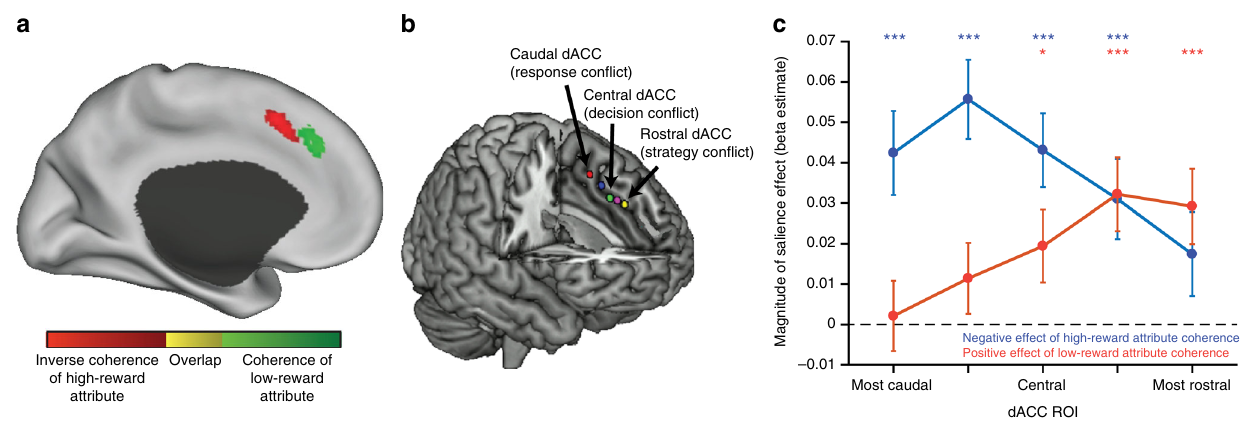
Fig. 4 dACC encoding of attribute coherence varies along rostrocaudal axis. a A nonparametric whole-brain analysis revealed that more caudal regions of dACC negatively tracked the coherence of the high-reward attribute (red) and more rostral regions positively tracked the coherence of the low-reward attribute (green). Activations re fl ect t -statistics ( t > 3.35, p < 0.001), extent-thresholded to achieve a cluster-corrected family-wise error p < 0.05, and are displayed on the in fl ated CARET surface. b , c This rostocaudal pattern was con fi rmed with a set of independent ROIs drawn from an earlier study 32 (shown in b ), which proposed that these re fl ect a range of uncertainty/con fl ict levels, from low-level responses (e.g., motor actions) most caudally to more abstract responses (e.g., decisions and strategies) more rostrally. Coef fi cients and corresponding s.e.m. are plotted in c for regressions of BOLD activity on high and low attribute coherence, performed separately for each ROI. b Is republished with permission of the Society for Neuroscience, from Taren et al. 32 . * p < 0.05, *** p <